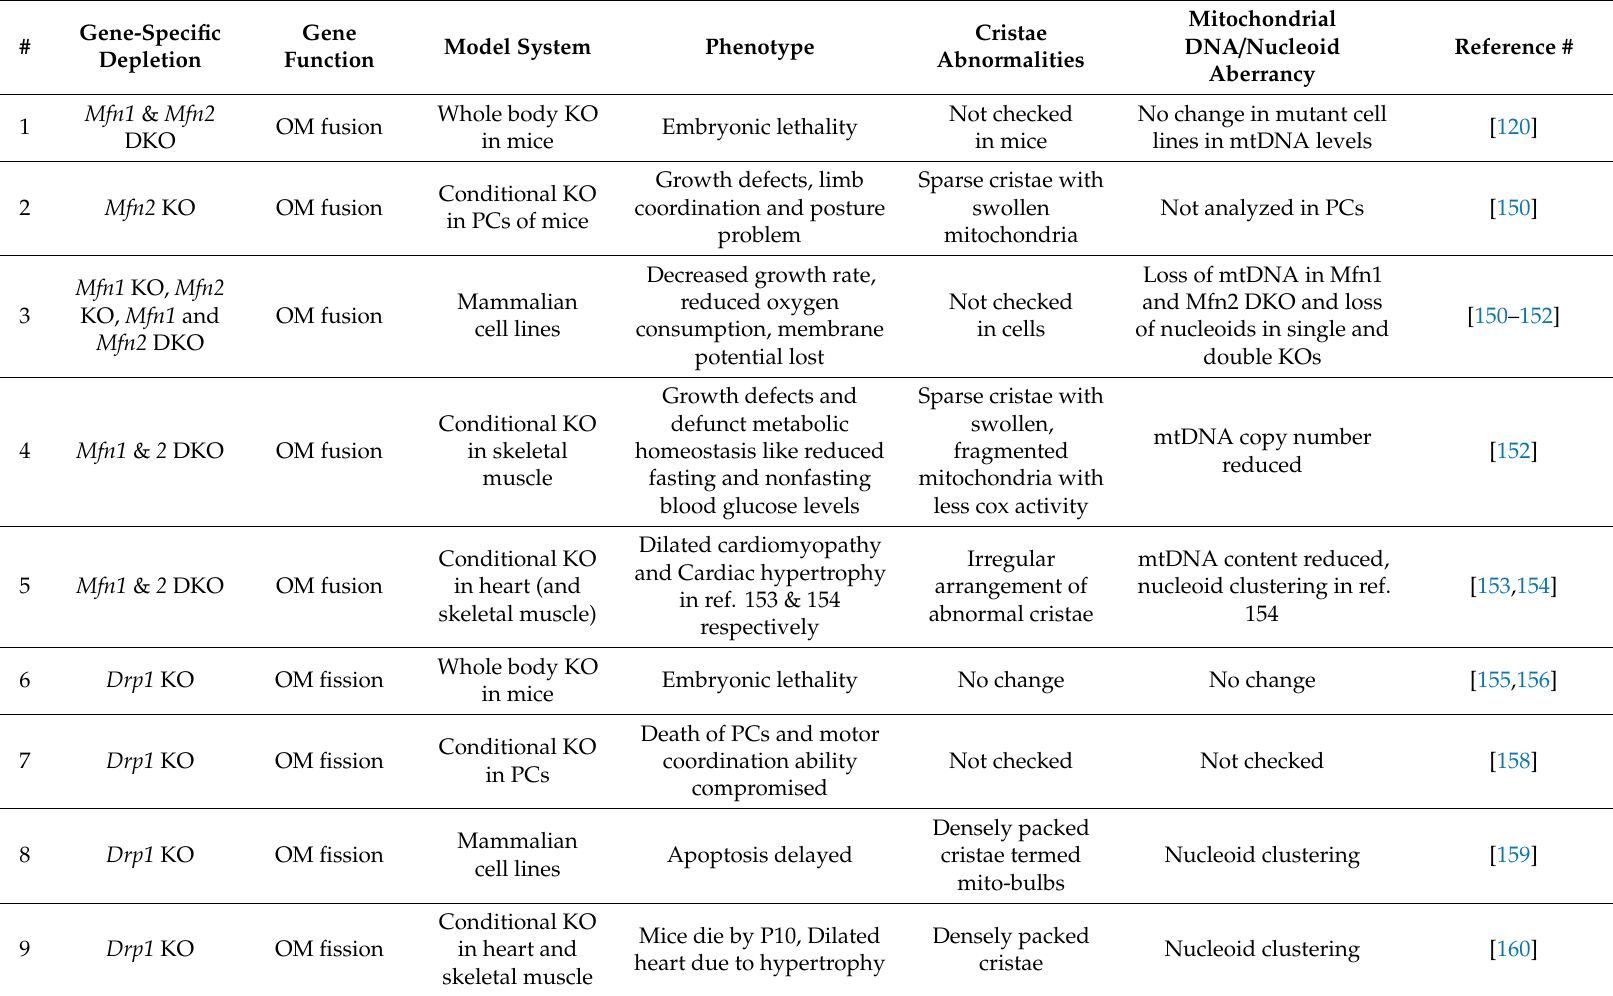
Table 1. Summary of phenotypes linked to deletion of factors involved in mitochondrial dynamics or cristae